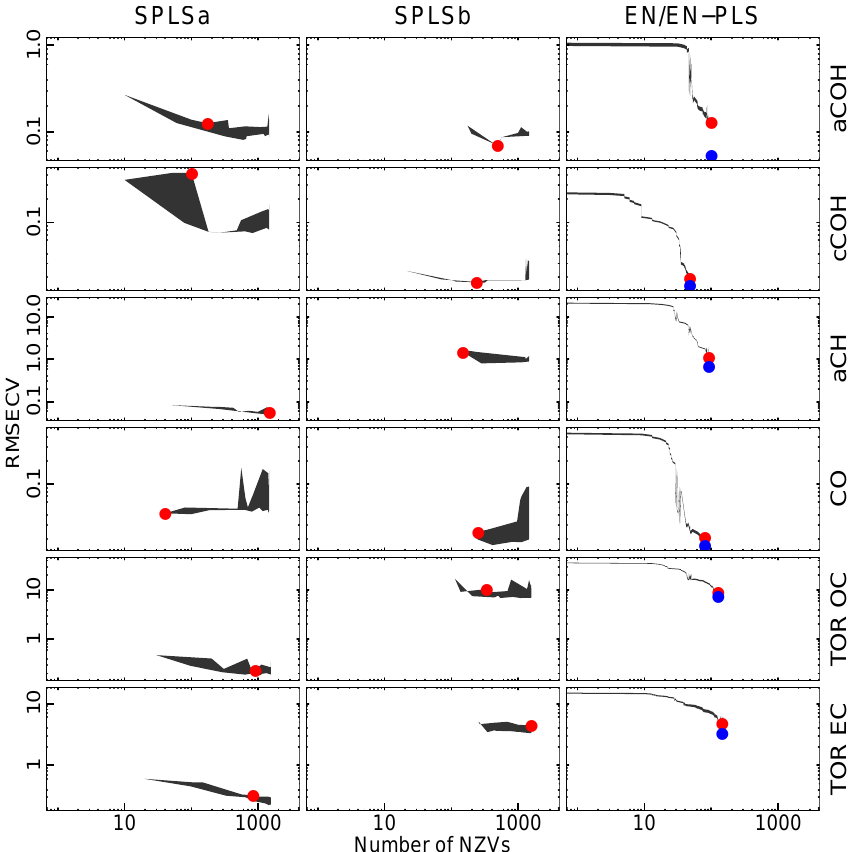
Figure 2. Same information as Fig. 1 is shown for models using baseline corrected